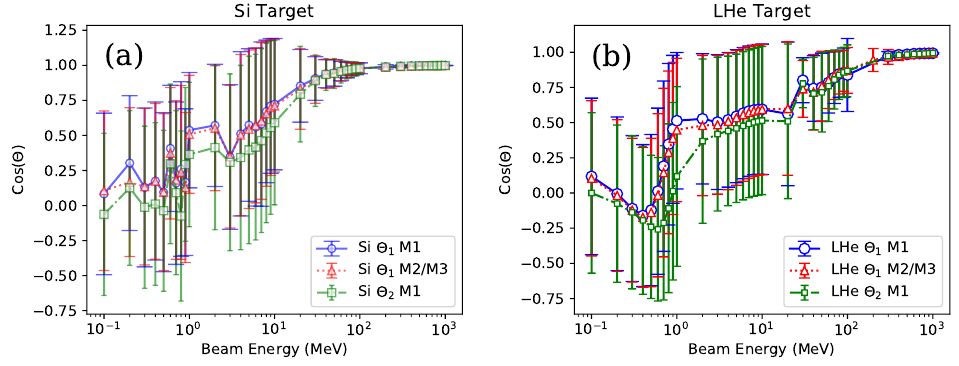
Figure 11. The cos ( Θ ) for Θ 1 and Θ 2 . ( a ) silicon target, ( b ) liquid helium